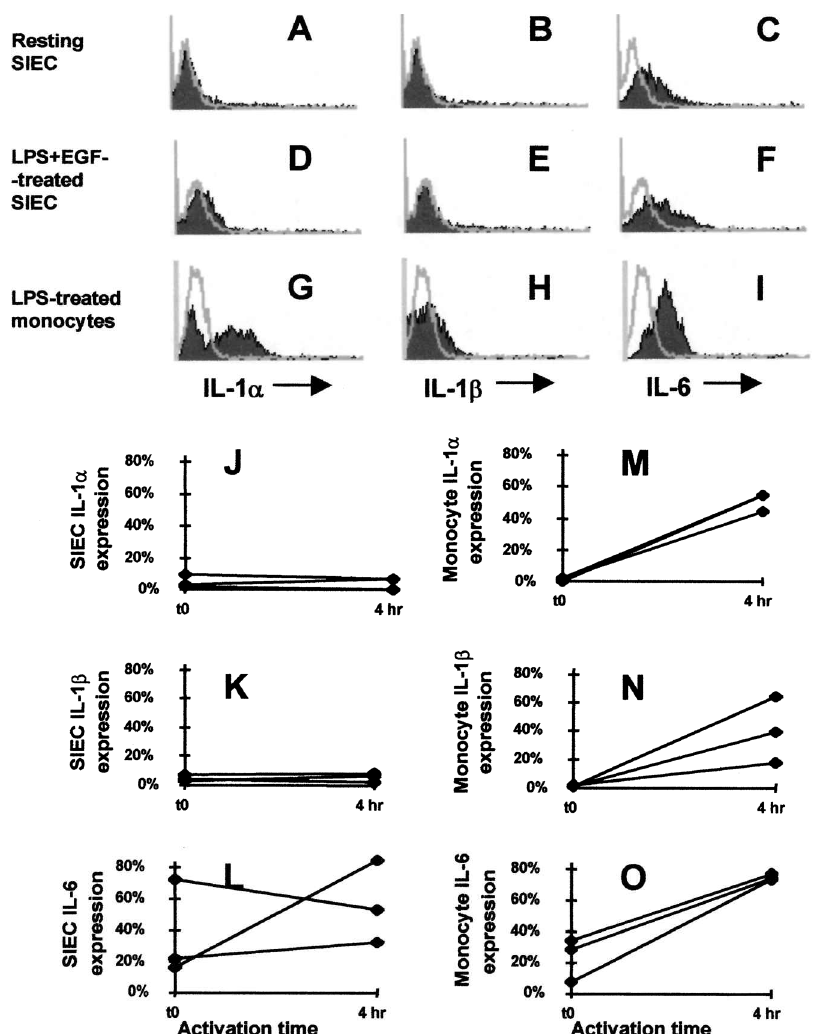
FIG. 3. IL-1 a , IL-1 b and IL-6 expression at time zero before activation ( t 0 ) and 4h following activation. (A-I) Flow cytometric analysis histograms showing intracellular IL-1 a , IL-1 b and IL-6 expression (A-C) by resting SIEC, (D-F) by SIEC after 4h activation, and (G-I) by activated monocytes from the same patient. Open histograms represent control background fluorescence, filled histograms show intra-cytoplasmic cytokine expression. (J-O) Summary of percentages of freshly-isolated SIEC expressing (J) IL-1 a , (K) IL-1 b and (L) IL-6 at t 0 and at 4h ( n = 3). Results are compared with those obtained for monocytes from the same patients for (M) IL-1 a , (N) IL-1 b and (O)